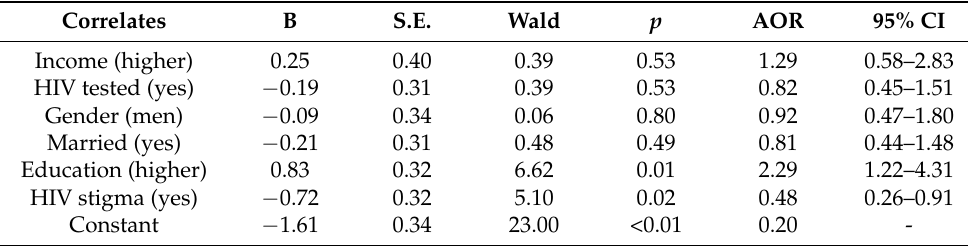
Table 5. Logistic regression predicting the likelihood of HIVST awareness ( n =